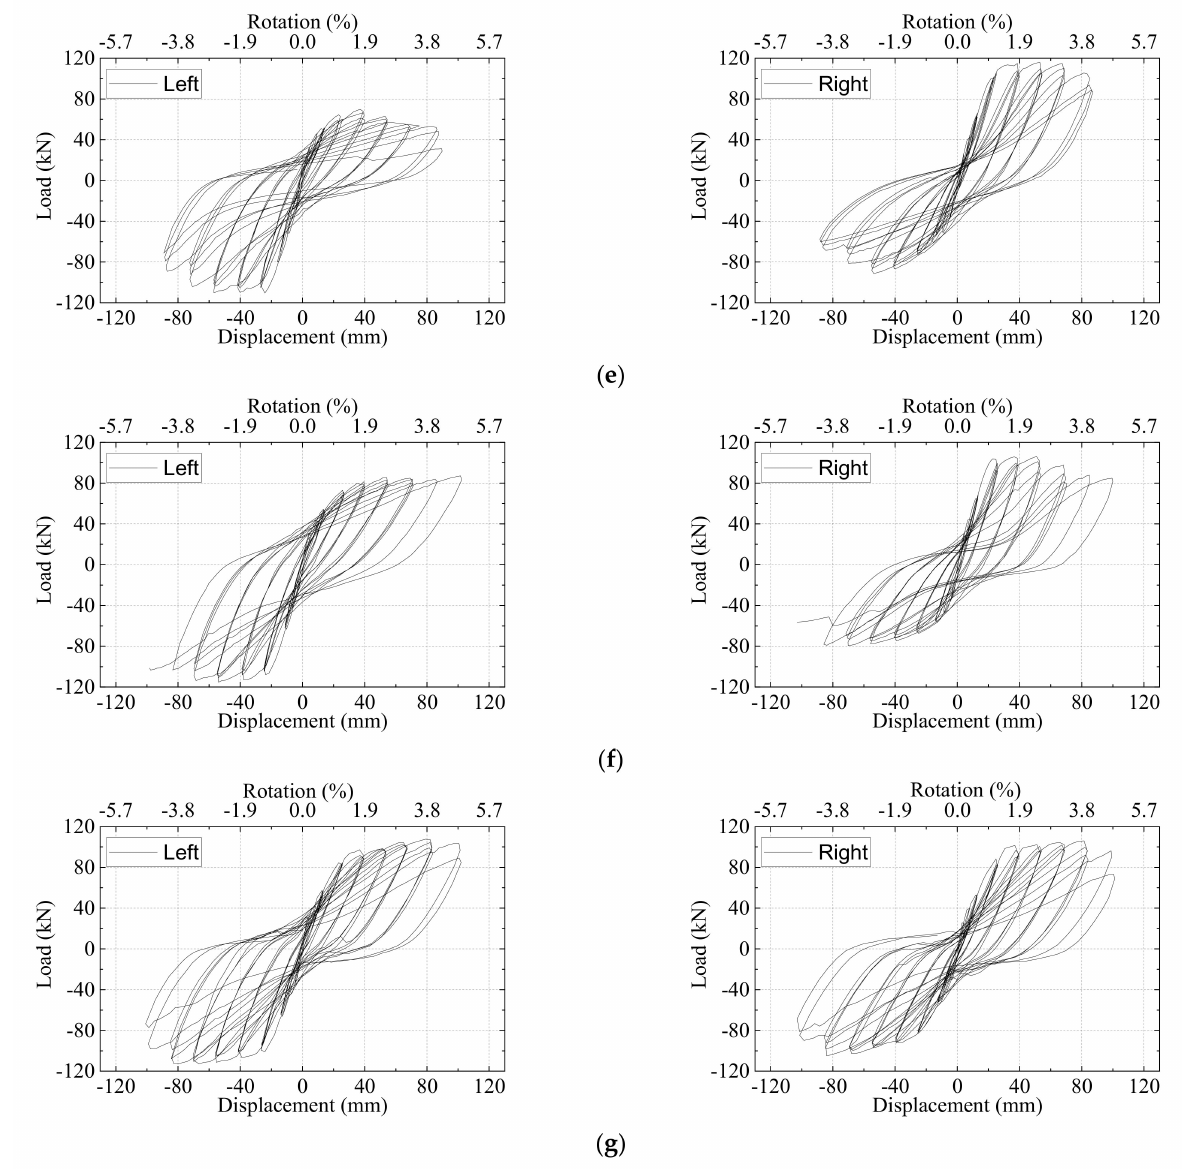
Figure 6. Hysteresis load–displacement curves. ( a ) Specimen PI1-L and PI1-R, ( b ) Specimen PI2-L and PI2-R, ( c ) Specimen PI3-L and PI3-R, ( d ) Specimen PI4-L and 4-R ( e ), Specimen PI5-L and PI5-R